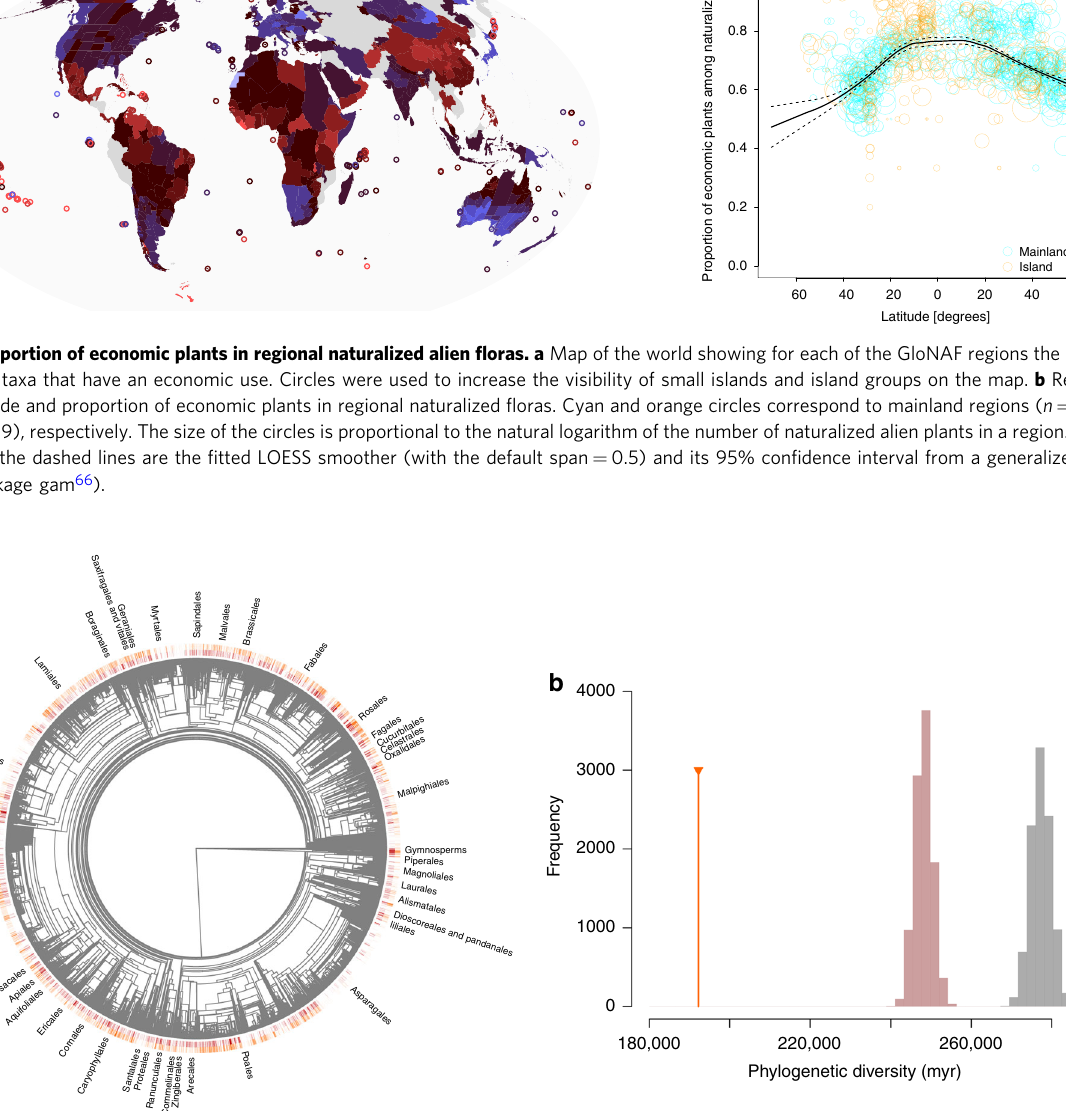
Fig. 8 Phylogenetic structure of economic use and naturalization success. a Phylogenetic tree of the extant global seed plant fl ora ( n = 326,101) showing the distribution of economic plants in red, and the distribution of naturalized taxa in orange at the tips of the tree. Gymnosperms and the names of the angiosperm orders with >500 taxa are provided for orientation. b Test for the role of economic use in the phylogenetic structure for naturalization success. The orange line shows the phylogenetic diversity (in million years, myr) encompassed by the full sample of naturalized plants. The gray histogram is the distribution of phylogenetic diversity expected among naturalized plants if they would be randomly drawn from the extant global fl ora. The red histogram is the distribution of phylogenetic diversity expected among naturalized plants if they would be randomly drawn from the extant global fl ora with the restriction that the proportion of naturalized taxa with economic use(s) remains the same as the observed proportion. A smaller than expected phylogenetic diversity indicates phylogenetic